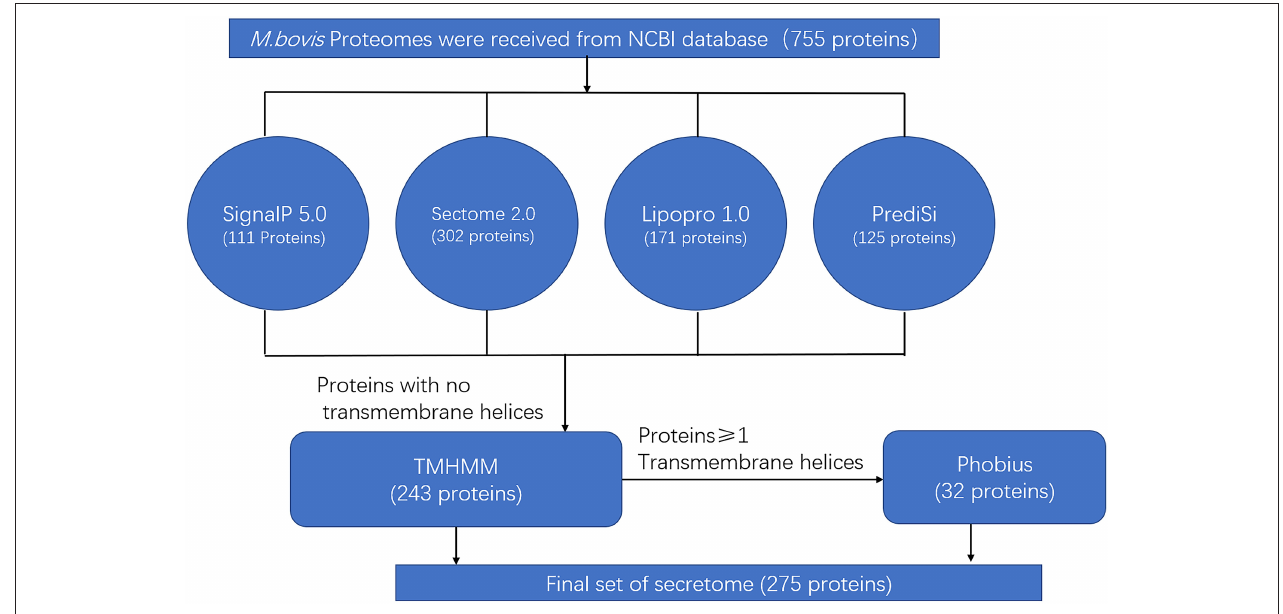
FIGURE 1 | Bioinformatics pipeline to identify the secretome of Mycoplasma bovis genome.